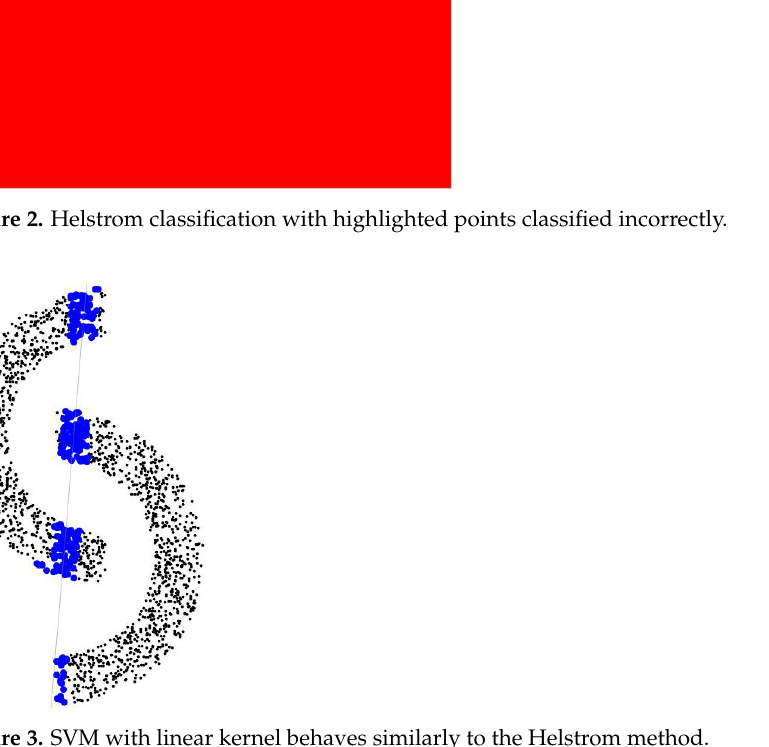
Figure 3. SVM with linear kernel behaves similarly to the Helstrom